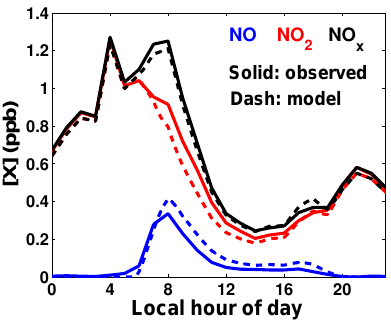
Figure 1. Comparison of simulated (dashed) and observed (solid) mixing ratios of NO (blue), NO 2 (red), and NO x (black) for the diurnal cycle setup described in Sect. 3.2. This simulation uses the “fix NO x ” option, which resets total NO x to the observed value at the start of every step (15min, in this case) while maintaining the model-calculated NO / NO 2